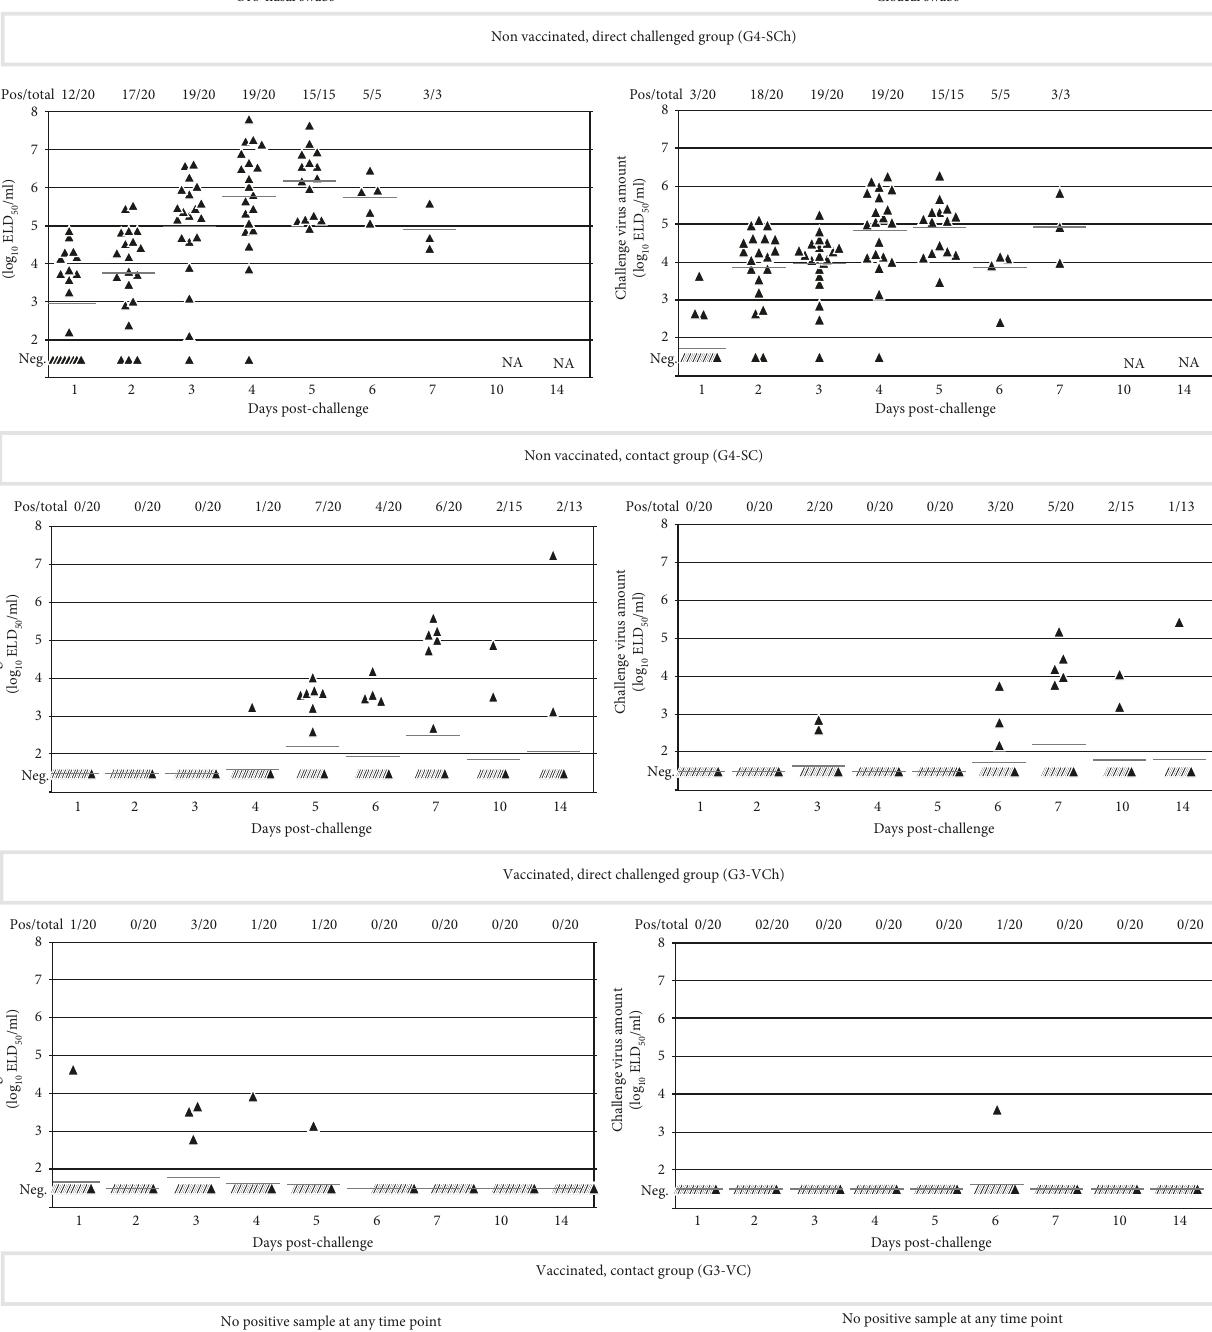
ELD /ml in the 10 50 10